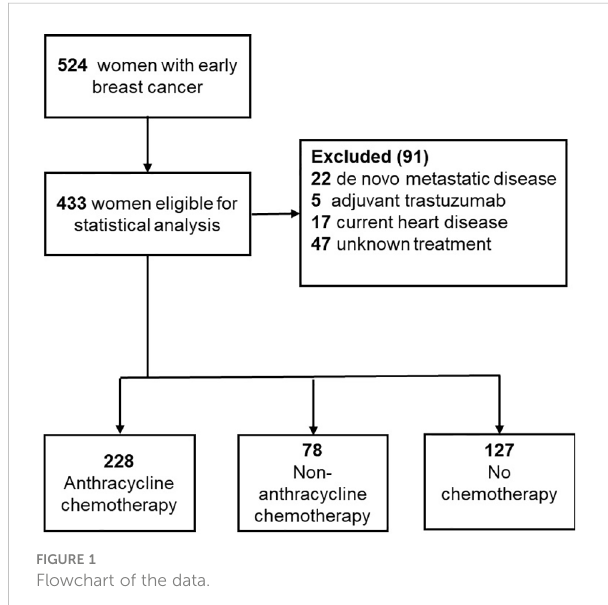
FIGURE 1 Flowchart of the